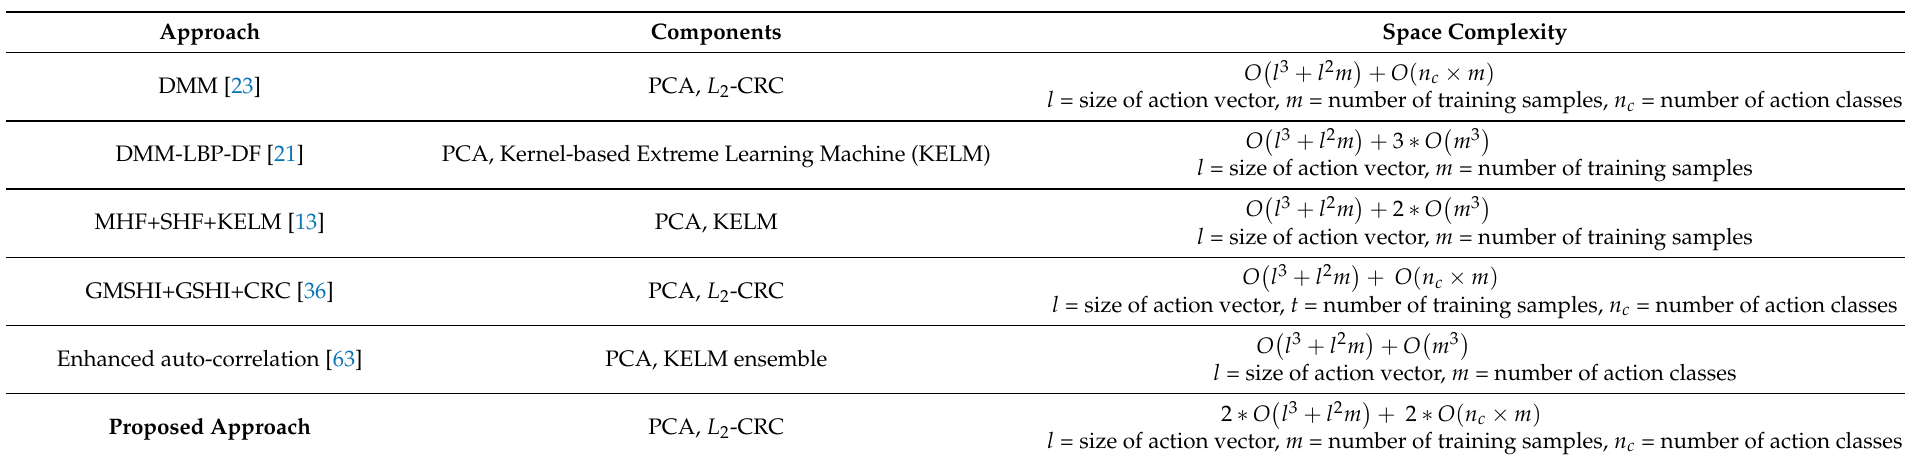
Table 8. Comparison of computational complexity of the proposed approach with other existing